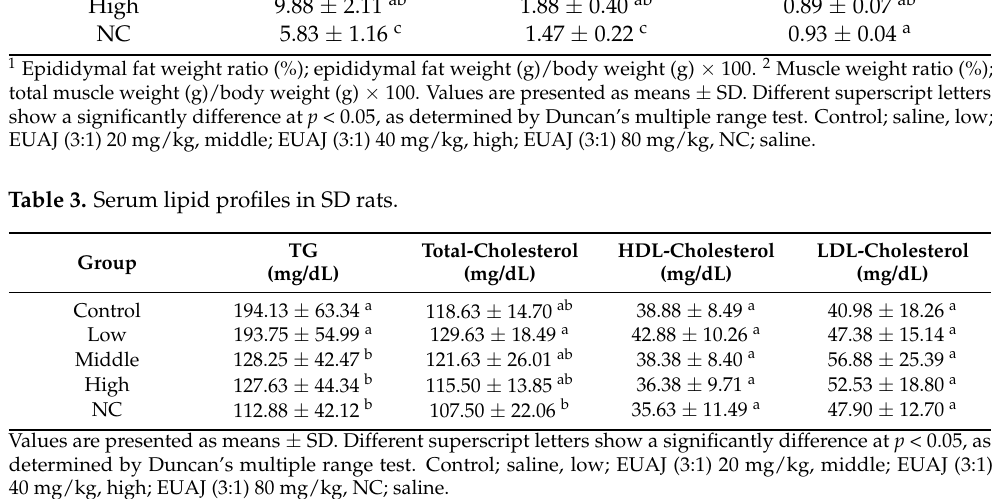
Table 2. The effects of EUAJ (3:1) on epididymal fat and muscle mass in SD rats. Epididymal Fat Group Weight (g)